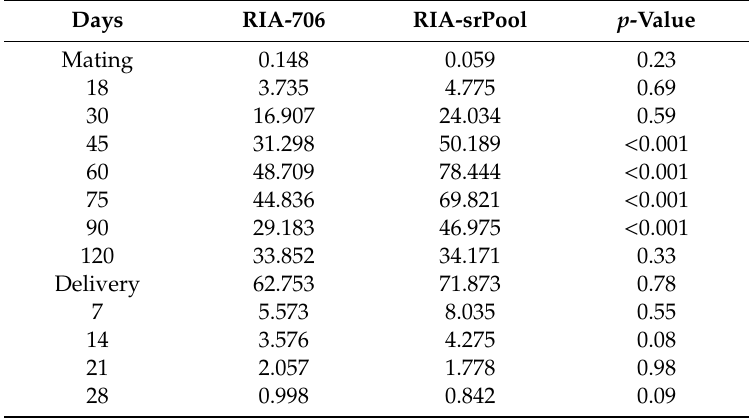
Table 1. Pregnancy-associated glycoprotein (PAG) values obtained before and after delivery according to radioimmune assay (RIA)